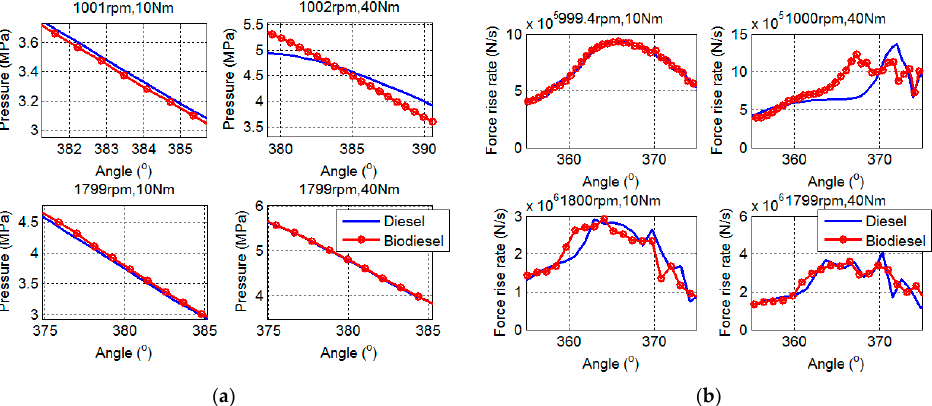
Figure 10. Piston side-thrust forces of alternative fuels under different operating conditions: ( a ) In-cylinder pressure around 380°-385°; ( b ) Peak values of force rise rate.